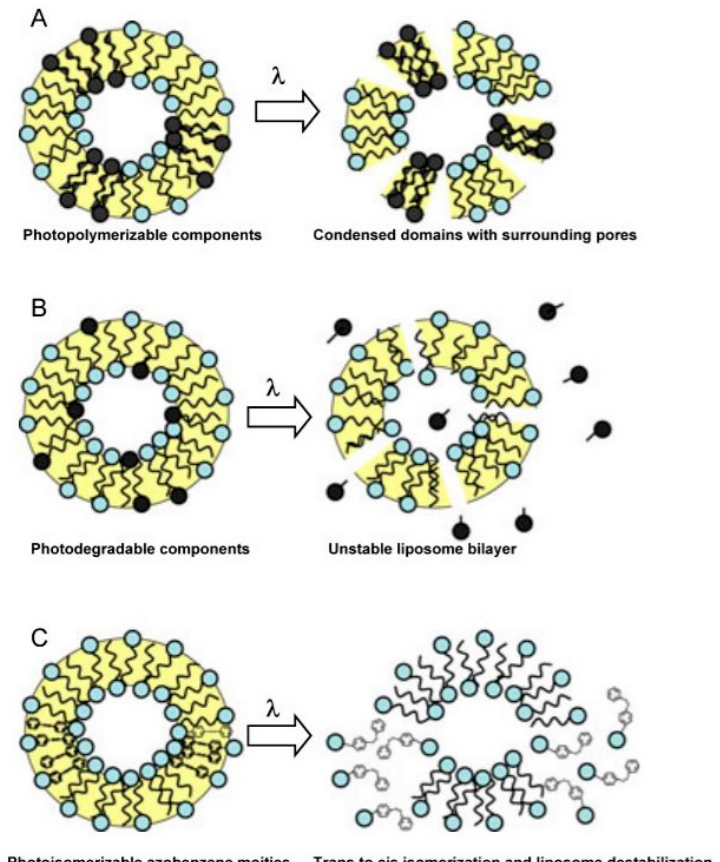
Figure 10. Schematization of light-triggered release mechanisms in liposomes by inclusion of: ( A ) photo-polymerizable components; ( B ) photodegradable components; or ( C ) photo-isomerizable azobenzene moieties. Reprinted with permission from [92]. Copyright 2012 Ivyspring International Publisher.